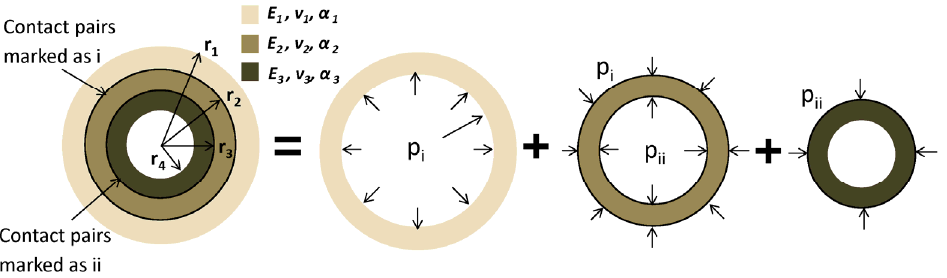
Figure 7. Superposition principle of tri ‐ layer thick ‐ walled cylinders without consideration of assembly order.